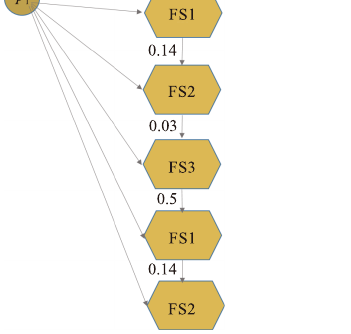
Fig. 3 Recoded health-seeking temporal graph of patient p Here, p indicates patient p and the rest of the nodes FS1, 1 i FS2, and FS3 represent different frequent disease-process subgraphs.